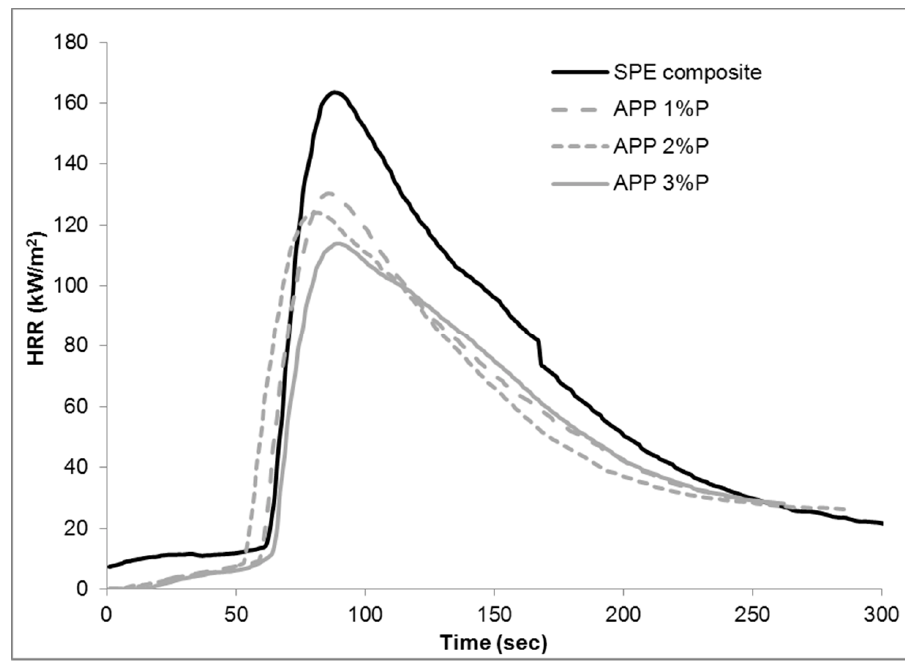
Figure 3. Heat release rate of reference and flame retarded SPE composites with ammonium polyphosphate (APP).